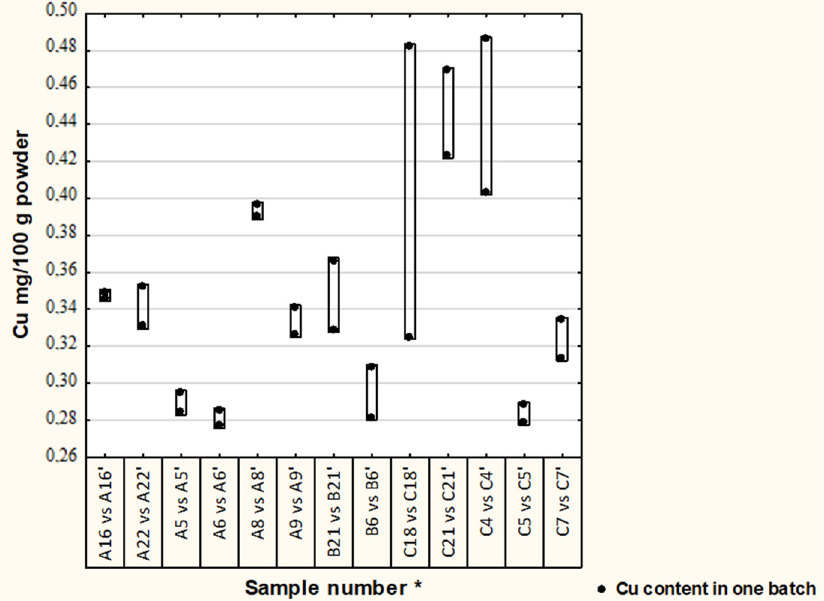
Figure 1. Differences in Cu concentration between batches of analyzed formulae. Second batch of the same formula, * randomly assigned formulae symbols from two other batches